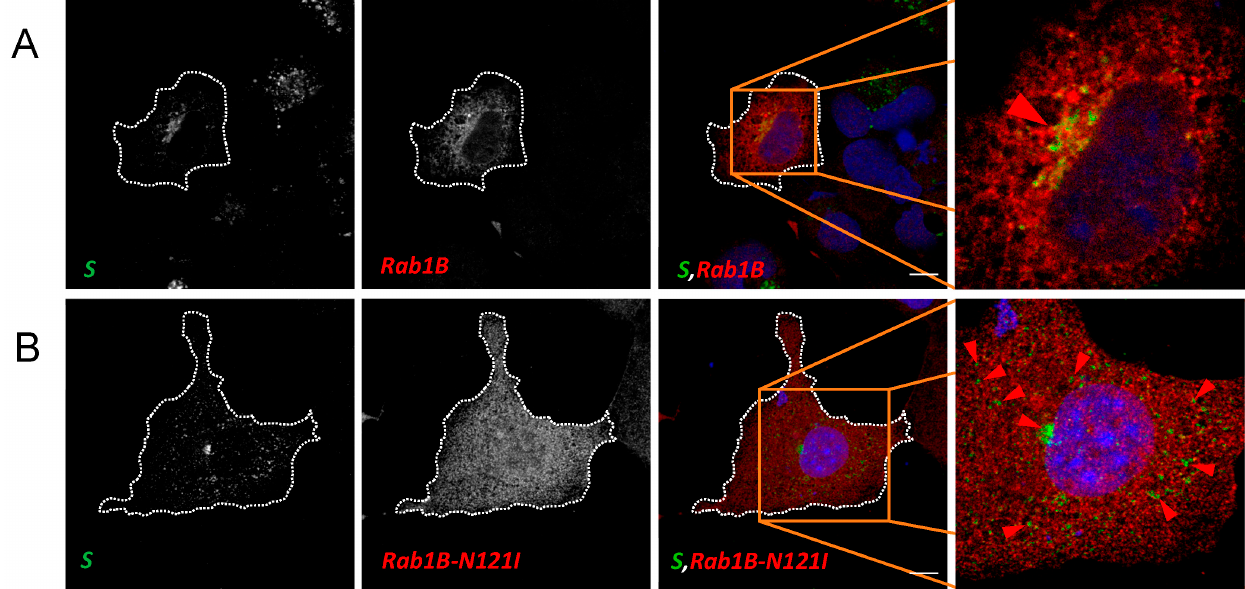
Figure 9. Inhibition of Rab1B leads to redistribution of SARS-CoV-2 S in infected HEK293 ACE2 cells. Subconfluent HEK293 ACE2 cells were infected with SARS-CoV-2 and subsequently transfected with 1000 ng ( A ) pCMV-Rab1B-myc or ( B ) pCMV-Rab1B-N121I-myc, respectively. Next, 24 hpt cells were fixed and stained for SARS-CoV-2 S (green), Rab1B (anti-myc, red) and nuclei (DAPI). Magnified region shows the difference in the distribution of S. Scale bars indicate 10 µ m. Data representative of three independent